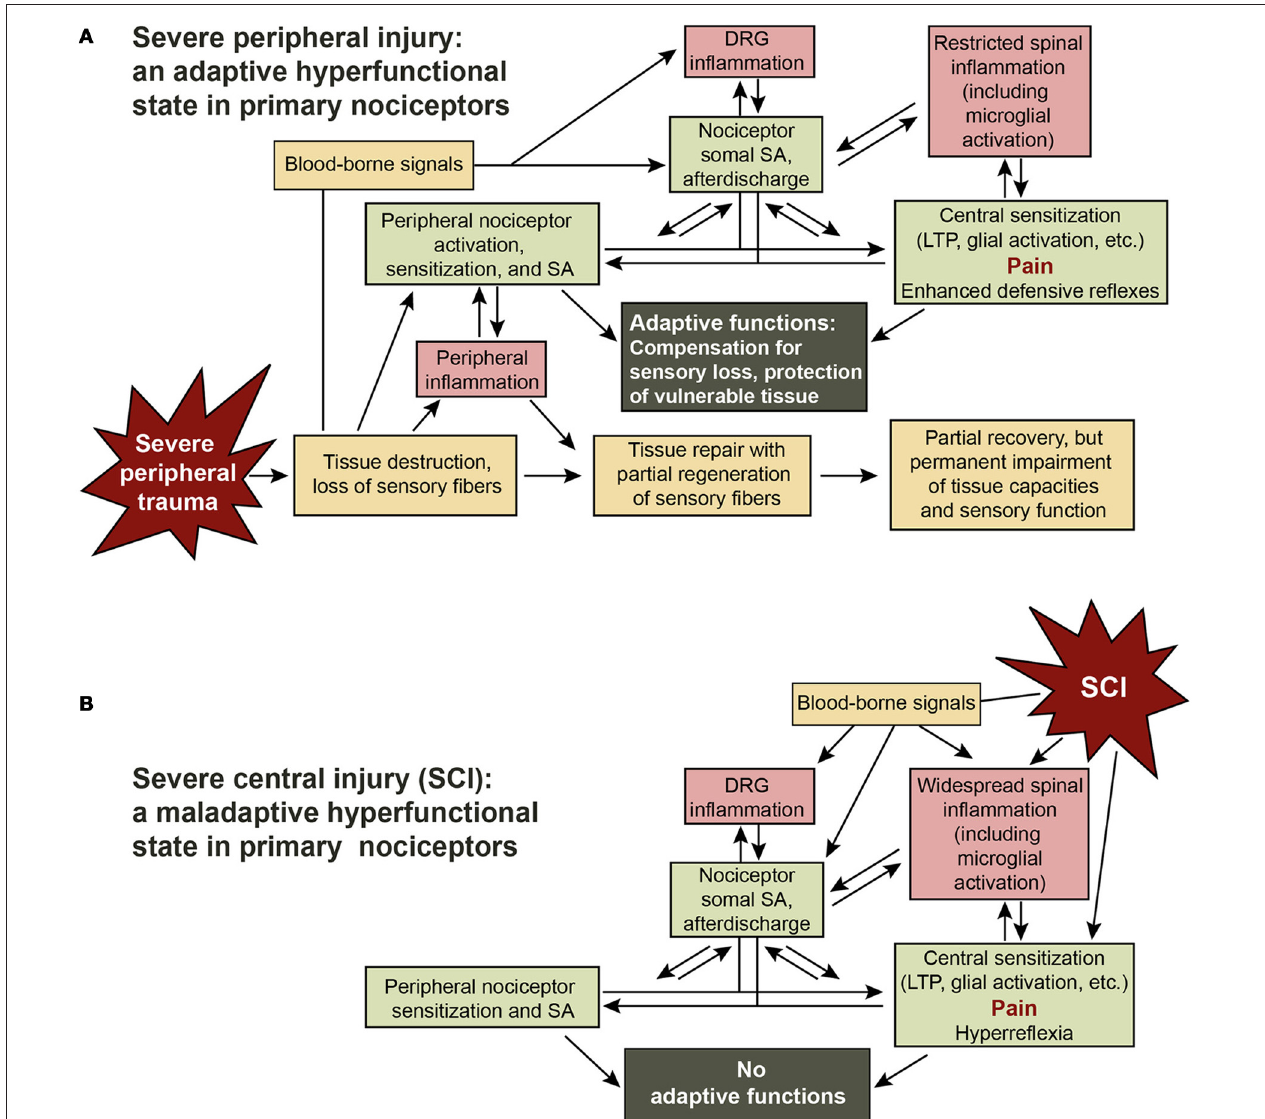
FIGURE 2 | Adaptive-maladaptivenociceptor hyperfunctional state hypothesis. (A) Adaptive nociceptor-driven sensitization and pain after severe peripheral injury. Compensation for permanent impairment of peripheral sensory function and protection of weakened tissue are achieved by enhancing the function of surviving nociceptors that innervate the region of injury via peripheral sensitization and by peripheral and somal hyperexcitability that produce SA, afterdischarge, LTP, and activation of central neurons and glia. Some degree of localized chronic pain can be useful for enhancing awareness of and protecting a chronically weakened body part.